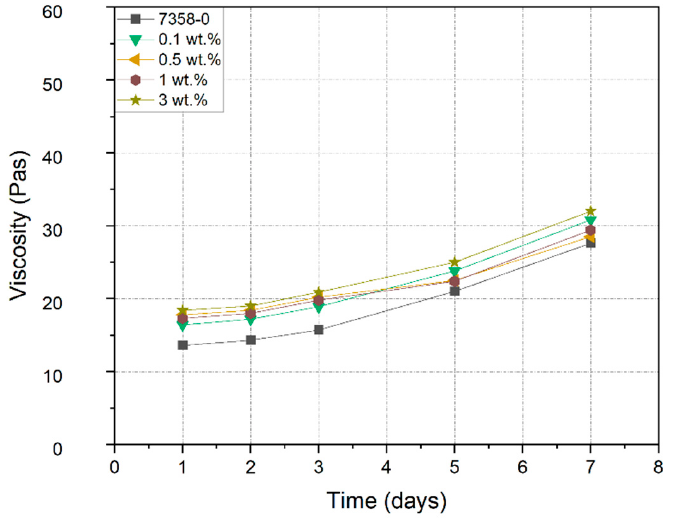
Figure 7. Influence of palygorskite-1.5MPTMS addition on Si-PSA composition viscosity.